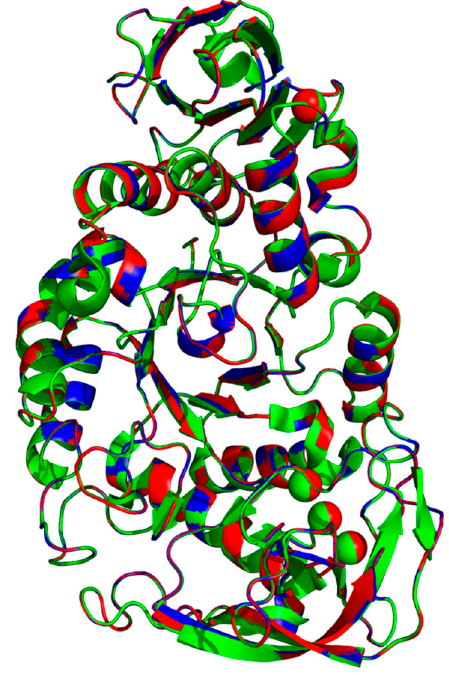
Figure 4. Superimposition of template 6ag0.1.A, WT and rc SR74 α -amylases. All polypeptides are colour-coded: 6ag0.1.A (green), WT (blue) and rc SR74 α -amylases (red). The pairwise root mean square deviation (RMSD) among three polypeptides were computed with and without the elimination of outliers.